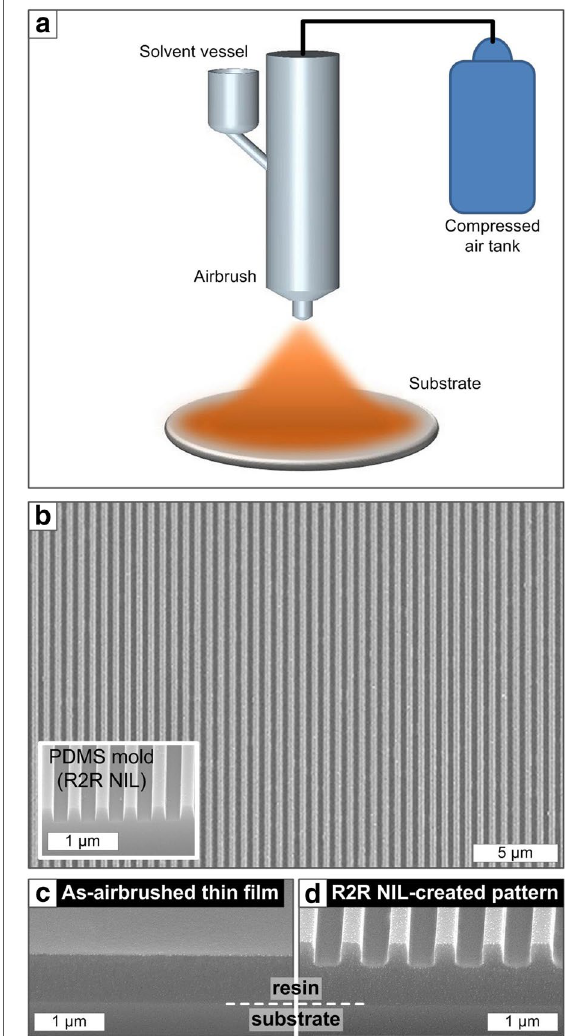
Fig. 1 Schematics of airbrushing and exemplary results in R2R NIL. a Schematic illustration of an airbrushing process where the diluted polymer is airbrushed onto the substrate to form a uniform thin film. b SEM image ( top view ) of the nanograting pattern fabricated by performing R2R NIL on the UV-curable resin films airbrushed on a PET substrate. The inset to b shows the PDMS mold used in R2R NIL (45°-tilted SEM imaging). The 45°-tilted cross-sectional SEM images of c an initial thin film and d its nanoimprinted structure, obtained by airbrushing the 10 wt% SSQ on a Si